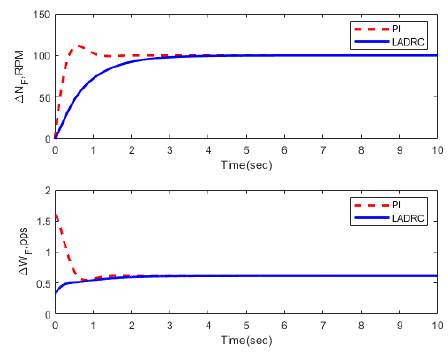
Figure 14. Step response of FC05.